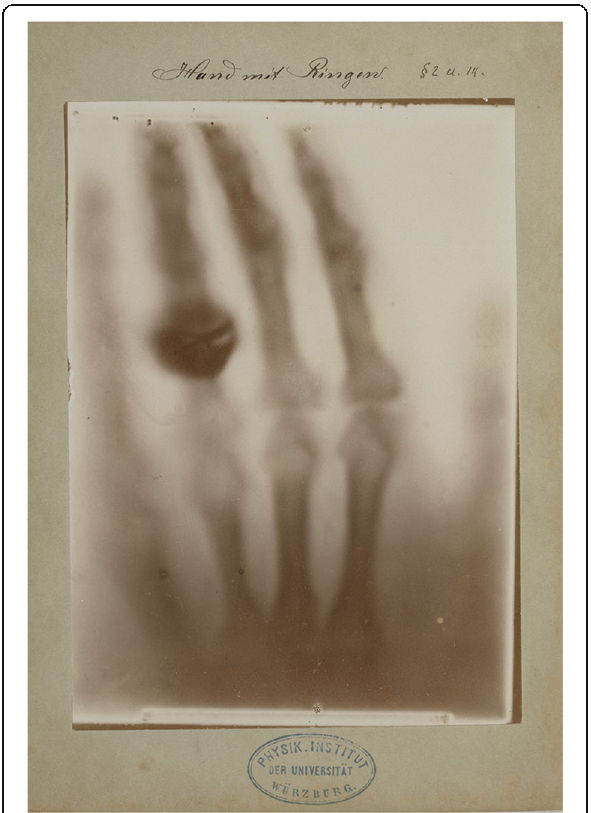
Fig. 3 The most impressive radiographic image is the one taken on December 22nd, 1895 of Bertha ’ s hand as it is the only image which shows the importance of X-rays for medicine as it is the first anatomical radiograph. It is therefore seen as the beginning of radiography. For Time Magazine , it was the reason to nominate it as one of the 100 most influential photographs ever. The other eight